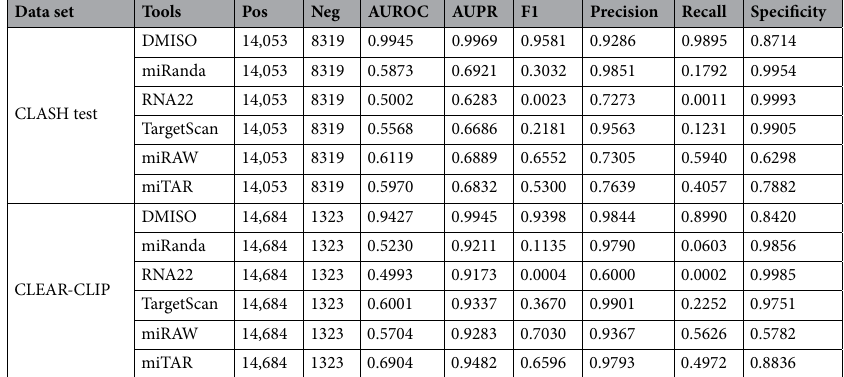
Table 1. Performance comparison on CLASH 20% test data and CLEAR-CLIP data.